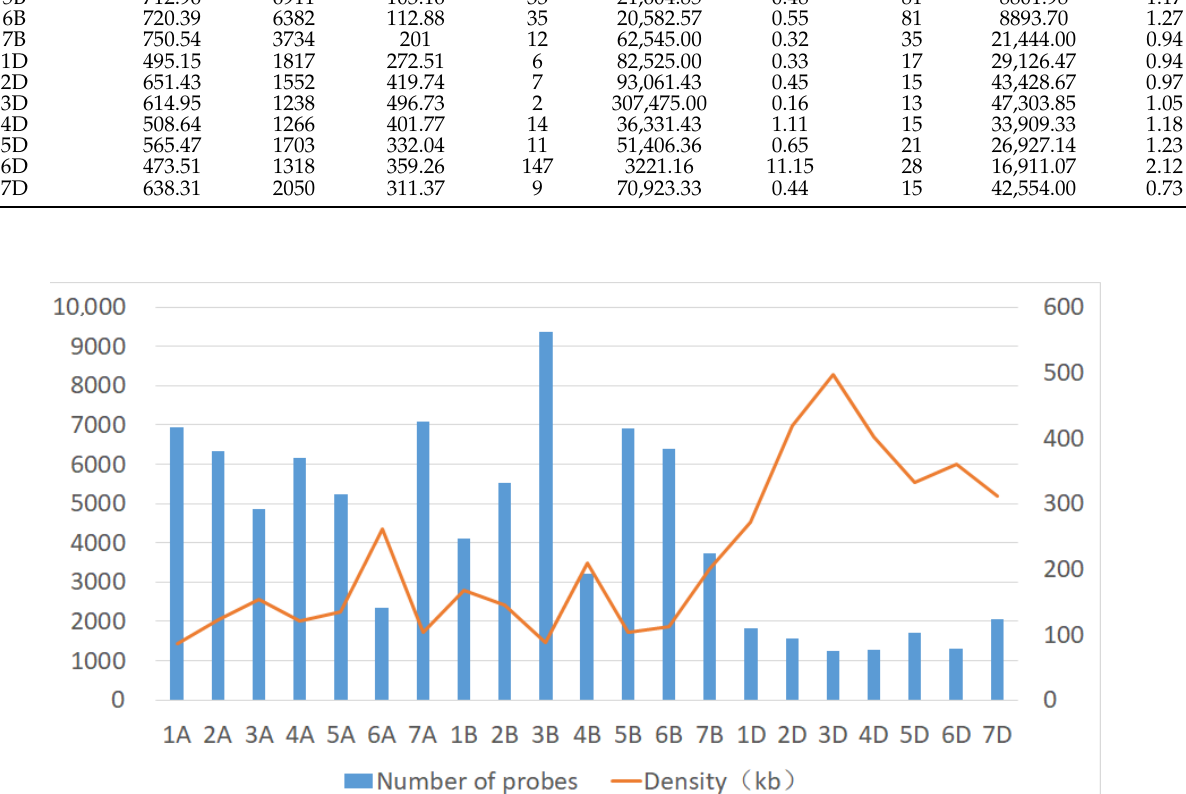
Figure 2. Distribution of 89,167 probes used for the genotyping. The abscissa shows the chromosome, the left ordinate shows the number of probes on each chromosome, and the right ordinate shows the density of the number of probes on each chromosome. The orange bars represent the number of probes, and the gray polyline shows the trend of density on each chromosome.